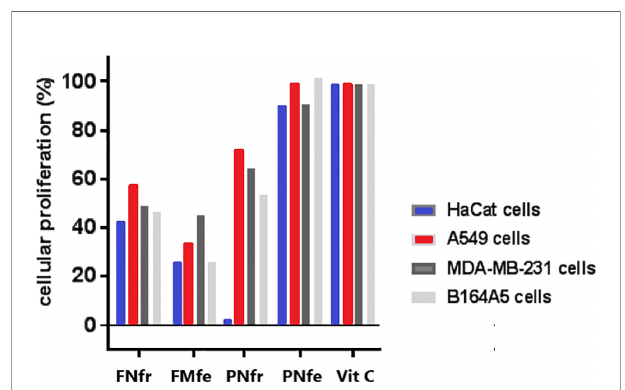
FIGURE 6 | Alamar blue cell proliferation assay. HaCat, keratinocyte; A549, human lung carcinoma; MDA-MB-231, human breast adenocarcinoma; B164A5, murine melanoma; FNfe, Feteasca ̆ neagra ̆ fermented grape pomace extract; FNfr, Feteasca ̆ neagra ̆ fresh grape pomace extract; PNfe, Pinot noir fermented grape pomace extract; PNfr, Pinot noir fresh grape